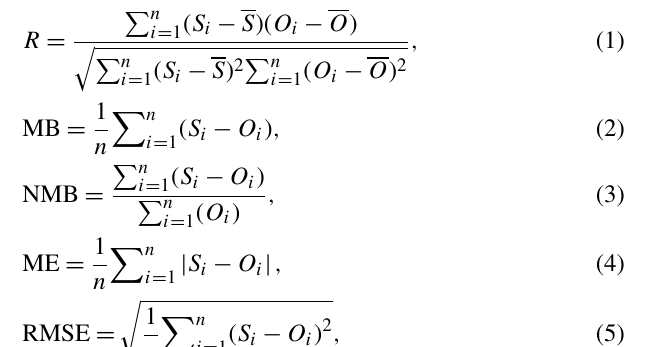
Instrument Objects Manufacturer PASCP-100X Aerosol number concentration, size distribution, etc. AE-33 temperature, wind speed,